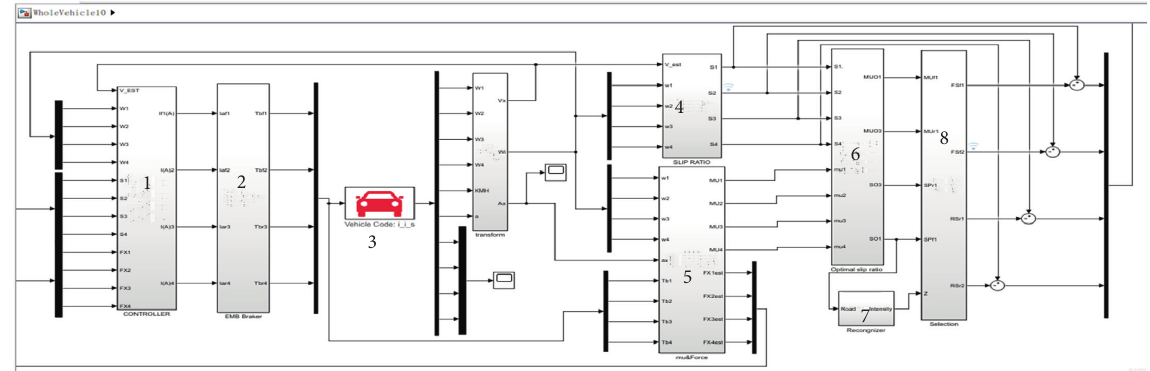
Figure 9: The structure of the simulation environment. 1: sliding mode controller. 2: EMB brake model. 3: CarSim vehicle model. 4: wheel slip rate calculation model. 5: wheel vertical load model. 6: pavement recognition model. 7: braking intention recognizer. 8: optimal braking force distribution strategy